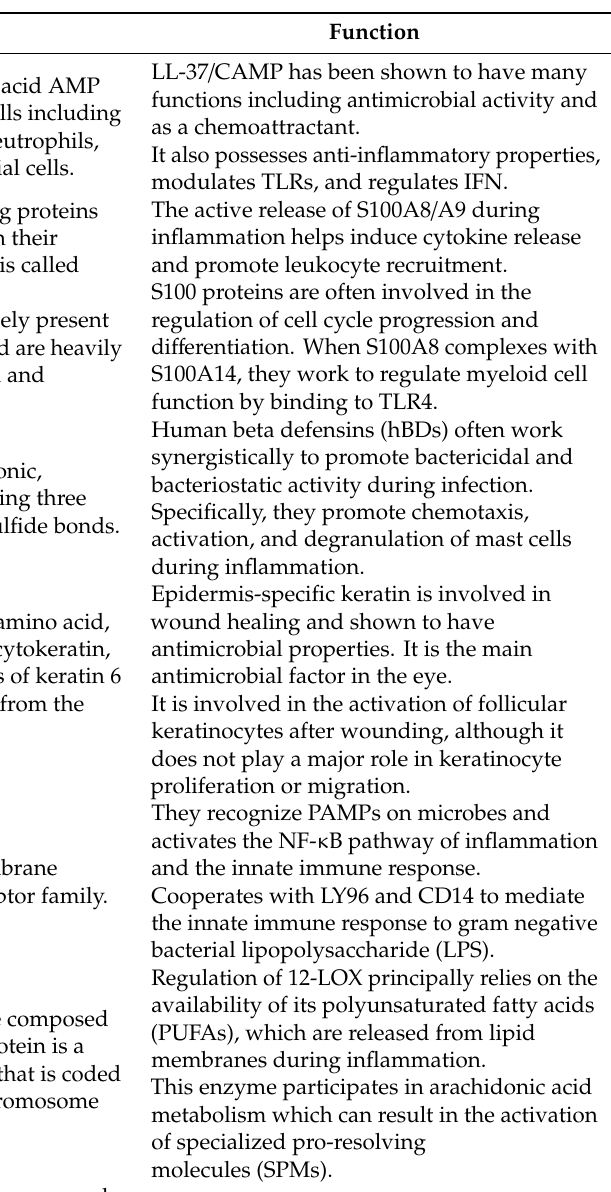
Table 1. Select antimicrobial peptides (AMPs) and related